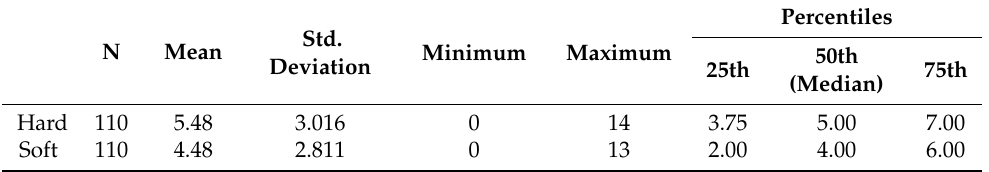
Table 17. Descriptive statistics of hard and soft skills within technical positions only.